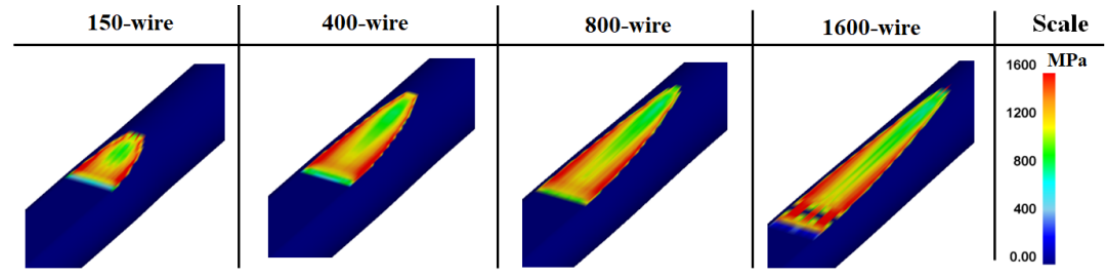
Figure 8. Comparison of the normal contact pressure on the wire surface with the roll diameter during wire flat rolling.